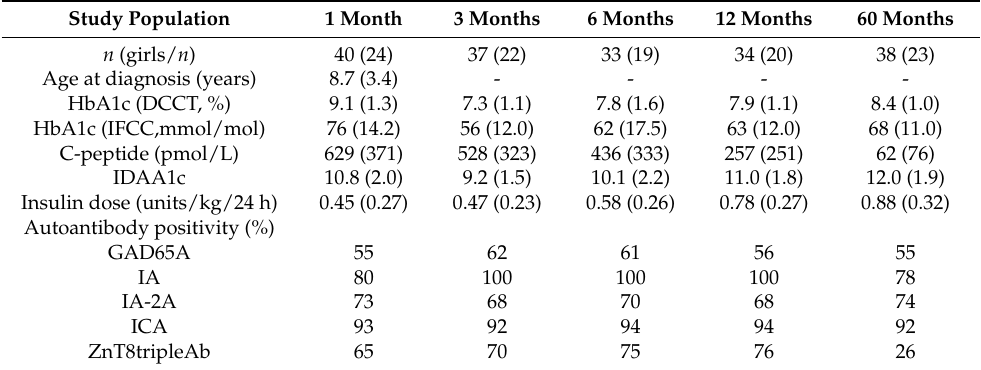
Table 1. Characteristics of 40 children and adolescents (study population) from the Danish Remission Phase Cohort and the entire cohort,